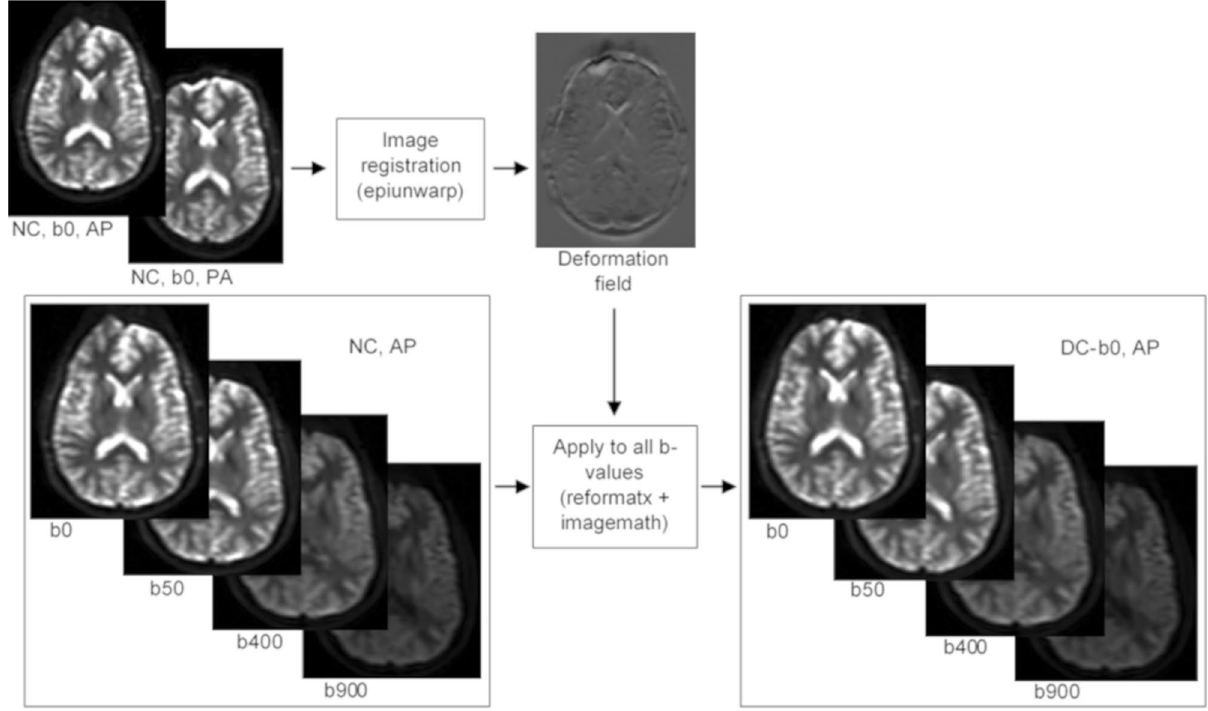
Figure 1. Illustration of the steps involved in the RPG geometric distortion correction. The CMTK tools epiunwarp, reformatx and imagemath were used as indicated. Epiunwarp calculates the 3D deformation field map from b0 AP and PA input images. The resulting deformation map then corrects all b-value images using the reformatx and imagemath tools. Reformatx applies the deformation map to each b-value image, while a voxel- wise multiplication with the Jacobian of the deformation is carried out using imagemath, correcting for signal